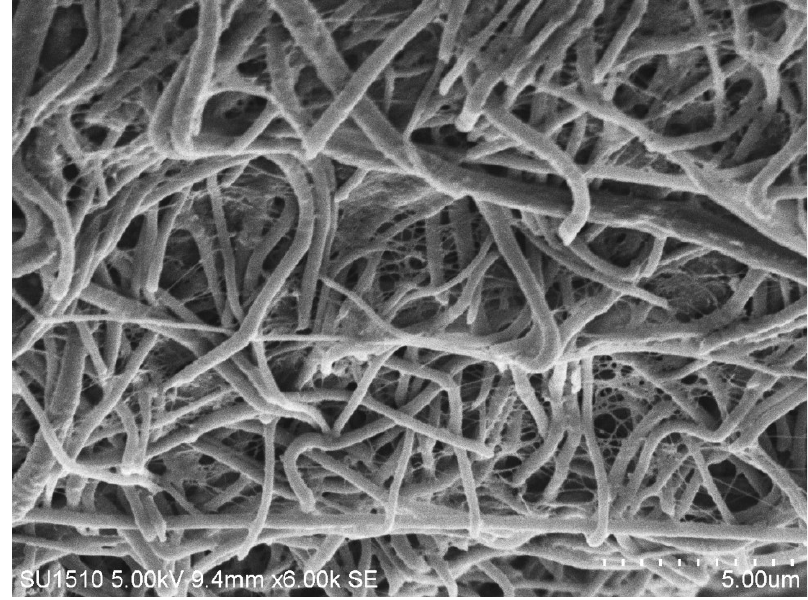
Figure 5. SEM images for BC/CA-ENM hybrid mats cross-sectional morphology.